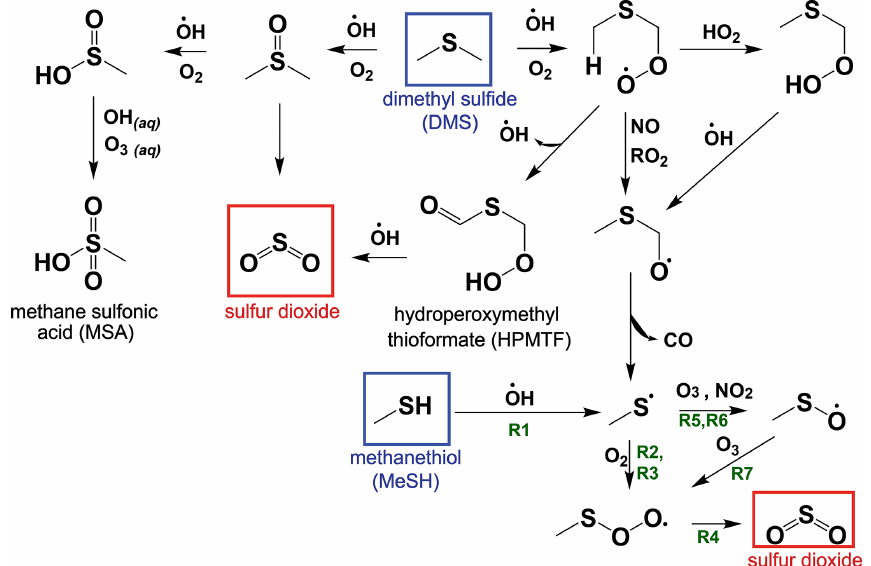
Figure 1. A simplified reaction scheme for the gas-phase oxidation of dimethyl sulfide (DMS) and methanethiol (MeSH) that focuses on pathways to SO 2 production. Reaction (R1) through Reaction (R7) described in Sect. 1.3 are labeled with green text on the schematic. Other chemical pathways including oxidation by halogens and most condensed-phase reactions of DMS and its oxidation products are not shown in this simplified schematic. Refer to Table S1 for a complete list of reactions and rate equations as implemented in this